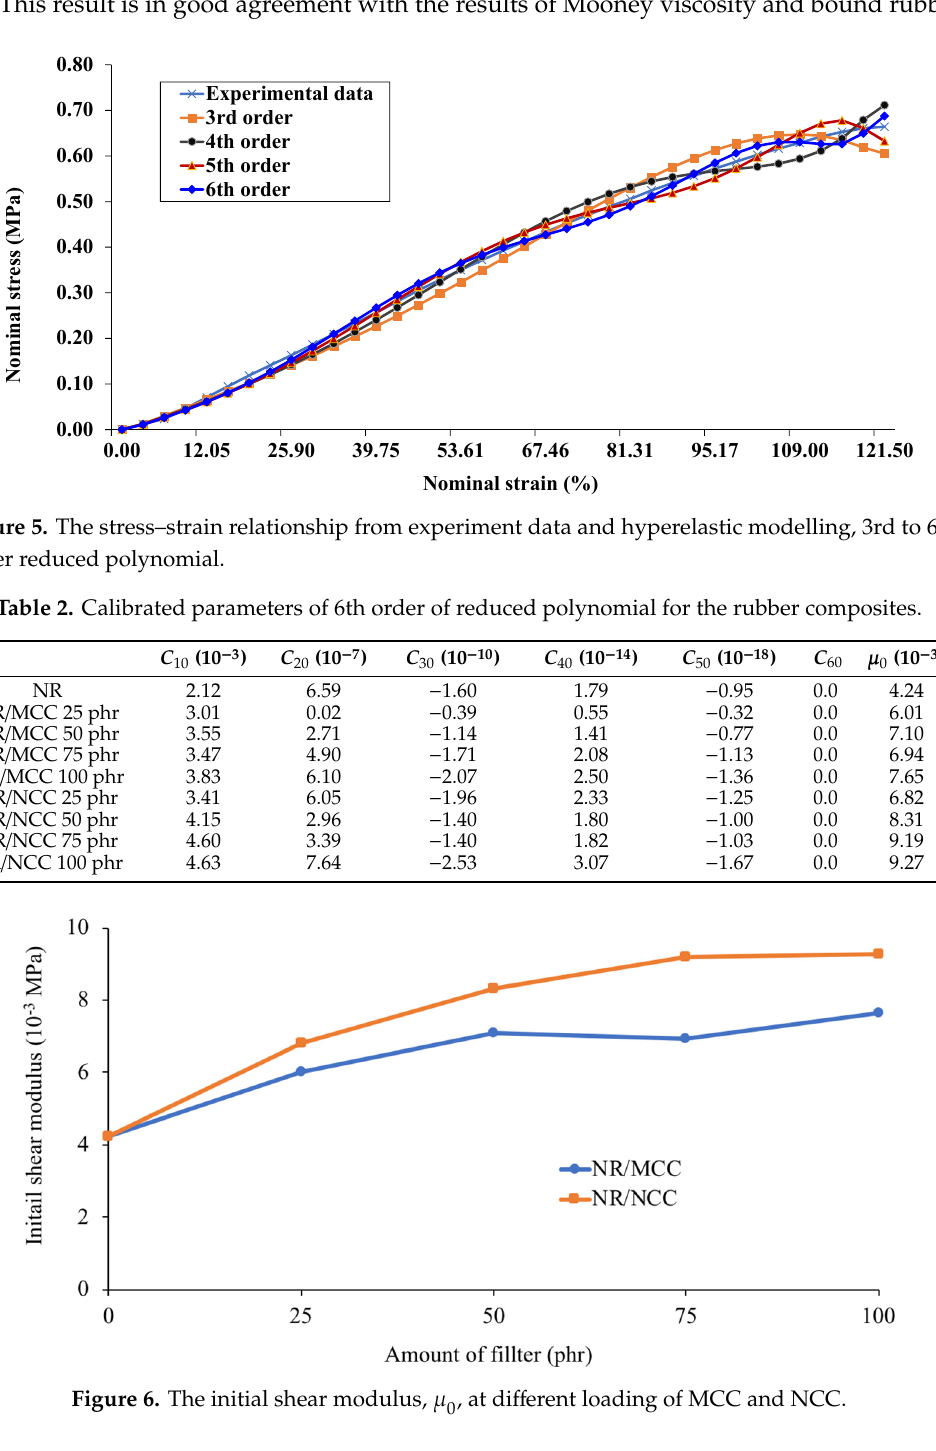
Figure 4. Bound rubber for natural rubber (NR) with various sizes (MCC vs. NCC) and amounts of filler (25, 50, 75, and 100 phr).